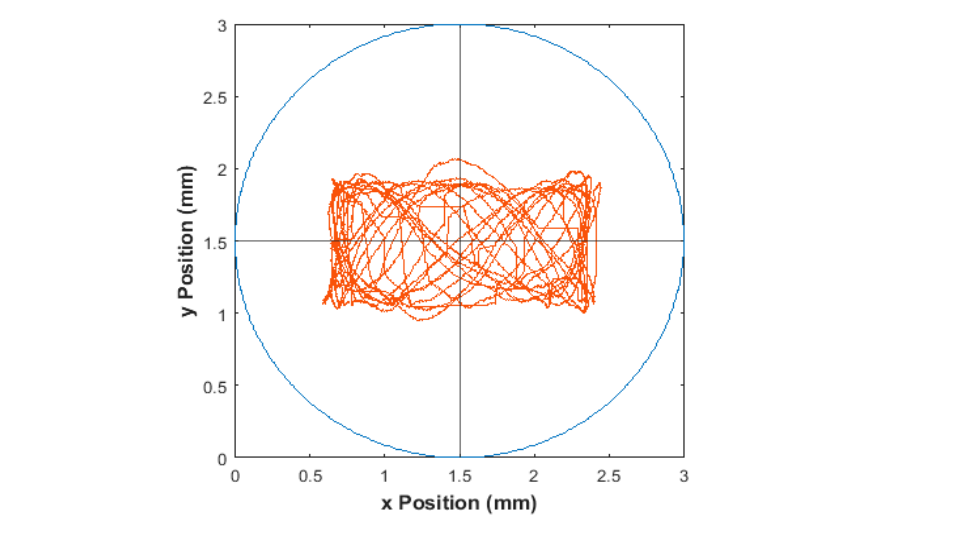
Figure 19. Orbit plot of rotor when spun at 1500 rpm, circle represents the allowable limit of movement for the rotor.